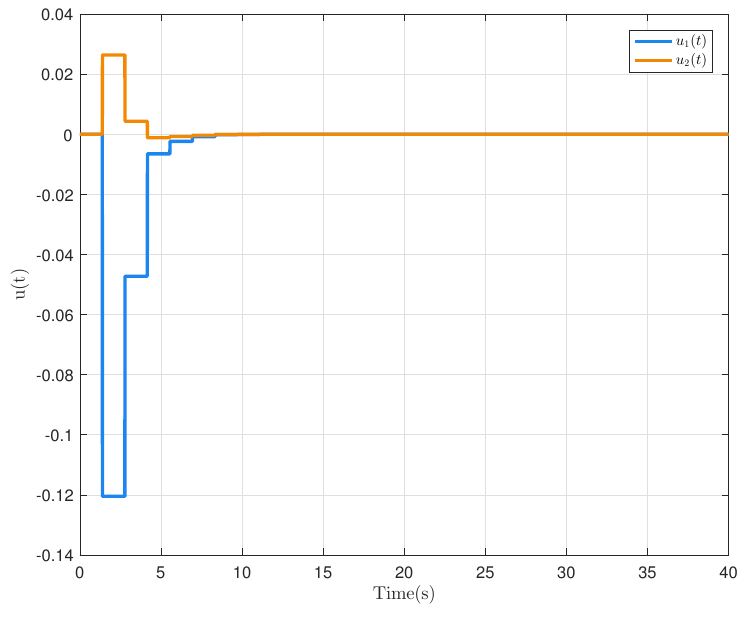
Figure 4. Control input u ( t )